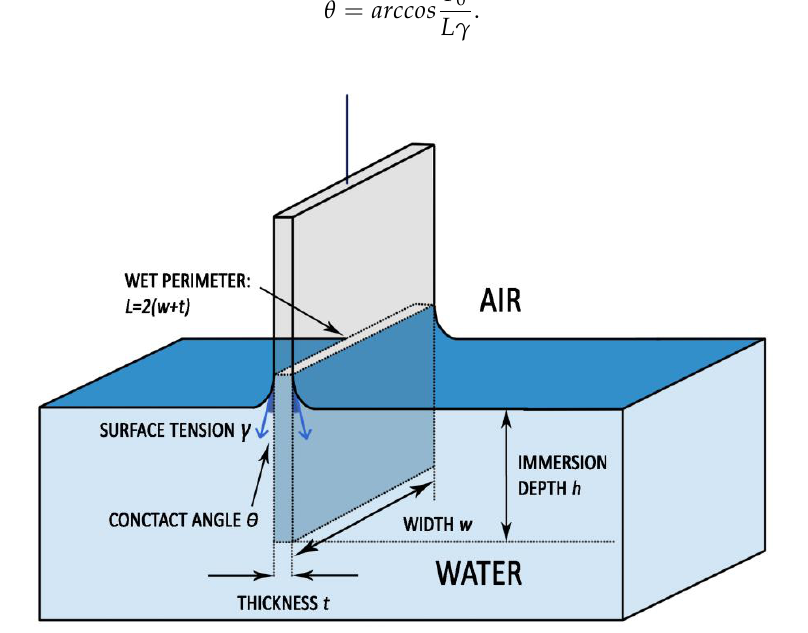
Figure 13. Schematic representation of surface tension acting during the sample immersion and emersion in water by means of force tensiometer when θ < 90°. For clarity’s sake, the surface tension effect was represented only for the longer sides of the wet perimeter.